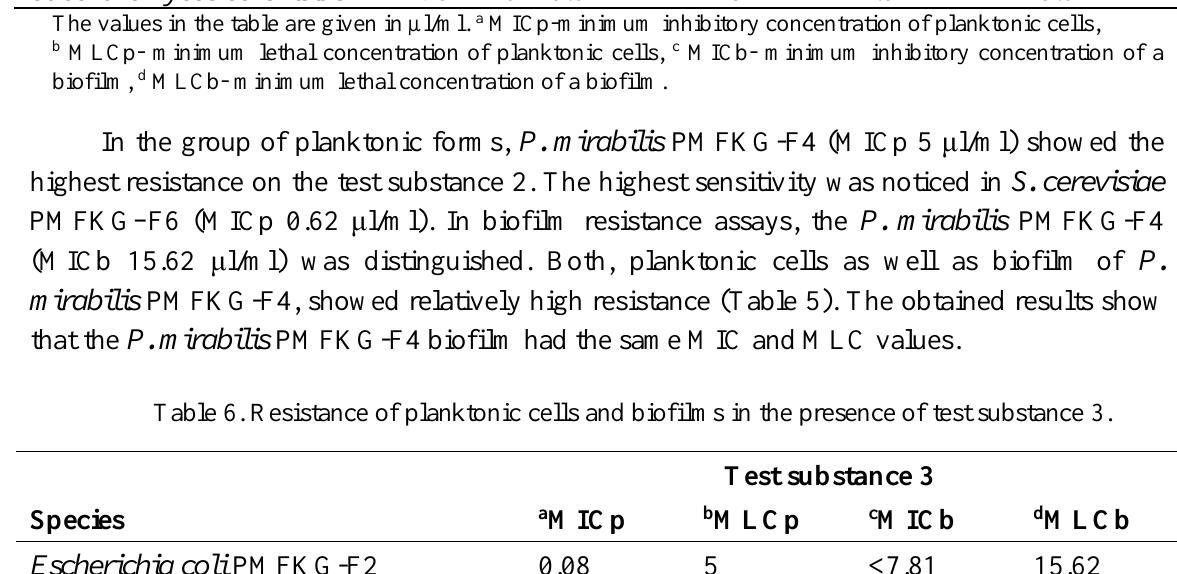
The values in the table are given in µl/ml. a MICp-minimum inhibitory concentration of planktonic cells, b MLCp- minimum lethal concentration of planktonic cells, c MICb- minimum inhibitory concentration of a biofilm, d MLCb- minimum lethal concentration of a biofilm.